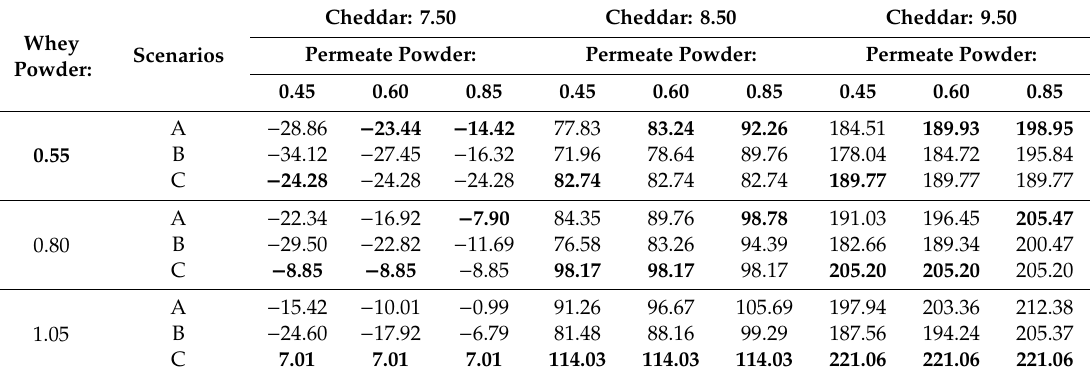
Bold values represent the most profitable (or the least detrimental) scenario for each economic condition. ($CAD · kg − 1 ) of the product and coproducts from scenarios A, B, and C.